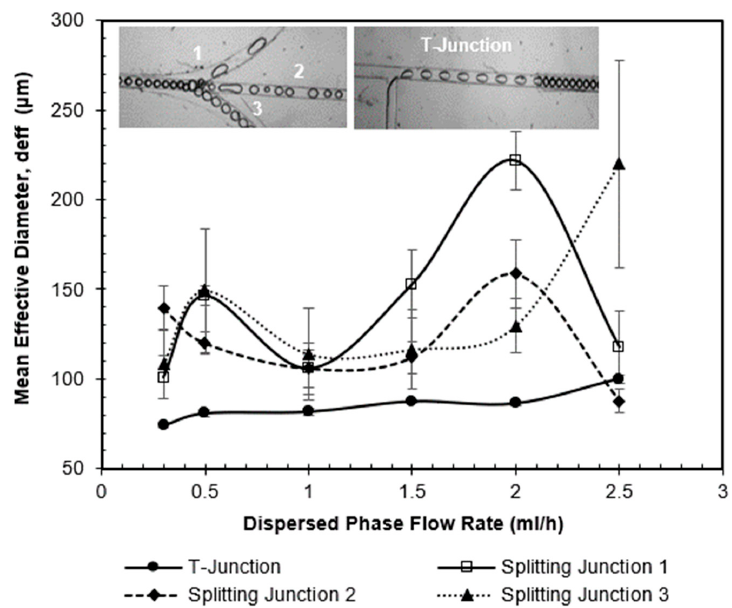
Figure 17. Average droplet size distribution with respect to different Q d ranging from 0.5 mL/h to 2.5 mL/h in asymmetrical bifurcating junction. Image indicates the region of interest for the droplet measurement. Error bars indicate the standard deviation in effective droplet size measurement of 30 droplets under fixed experimental condition.